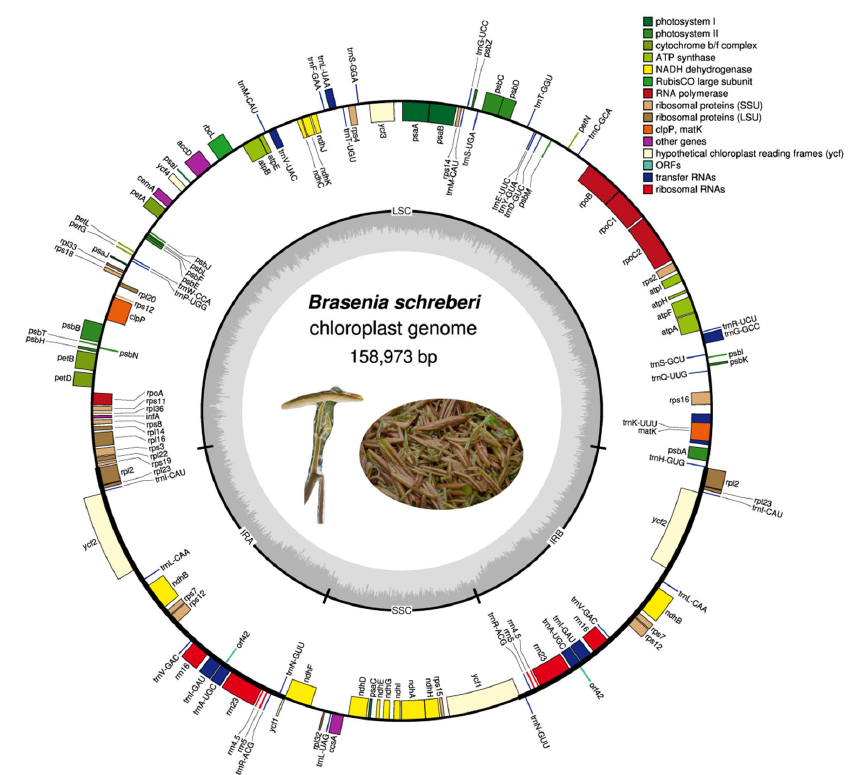
Figure 2. Physical map of the cpDNA genome of B. schreberi cv. ‘Mahu Chuncai’. The rectangles of different width represent various genes. Genes outside the circle are forward encoded, while genes inside the circle are reverse encoded. The smallest internal grey circle in grey shows the GC content. Table 1. List of genes in the B. schreberi cv. ‘Mahu Chuncai’ chloroplast genome.